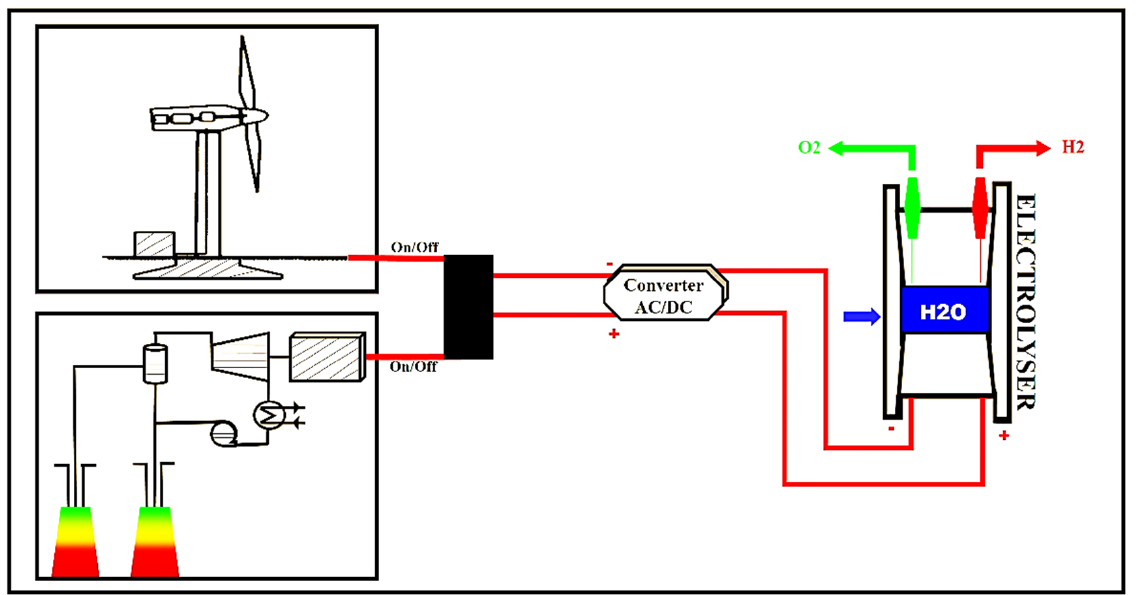
Figure 3. Simplified diagram of the hydrogen production from wind and geothermal energy.